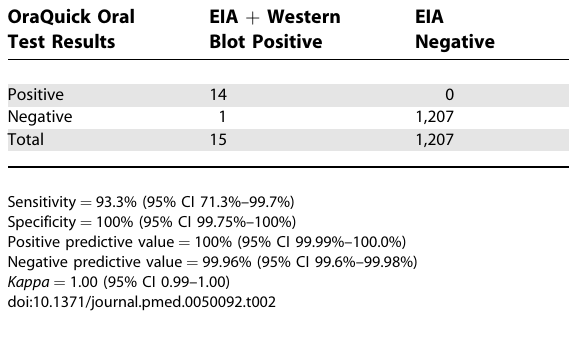
Table 3. Diagnostic Accuracy of OraQuick Finger-stick Test OraQuick Finger-Stick Test